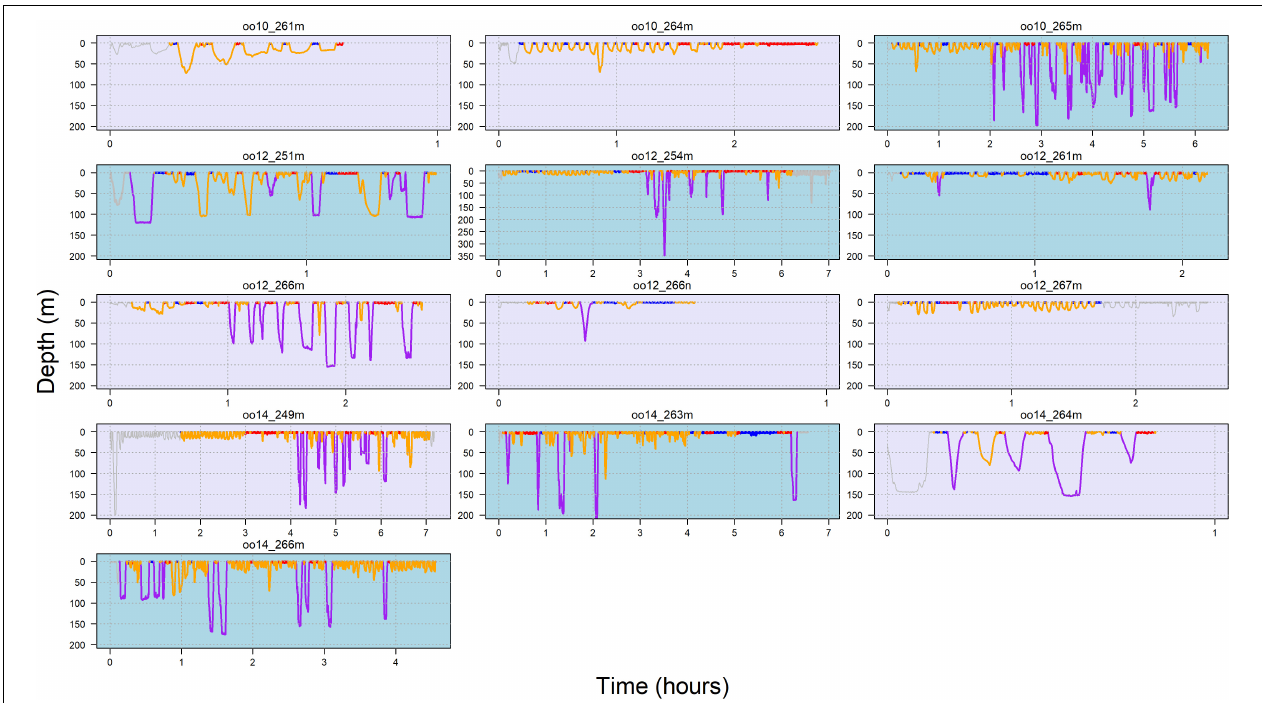
FIGURE 3 | Dive profile by behavioral state for each deployments over time. Note the difference in both x - and y -axis scale among plots. Female = lavender box, male = light blue box, state 1 = dark blue, state 2 = purple, state 3 = red, state 4 = orange. Gray dives indicate omitted 5-min interval at start of deployment and periods which vessel data were not